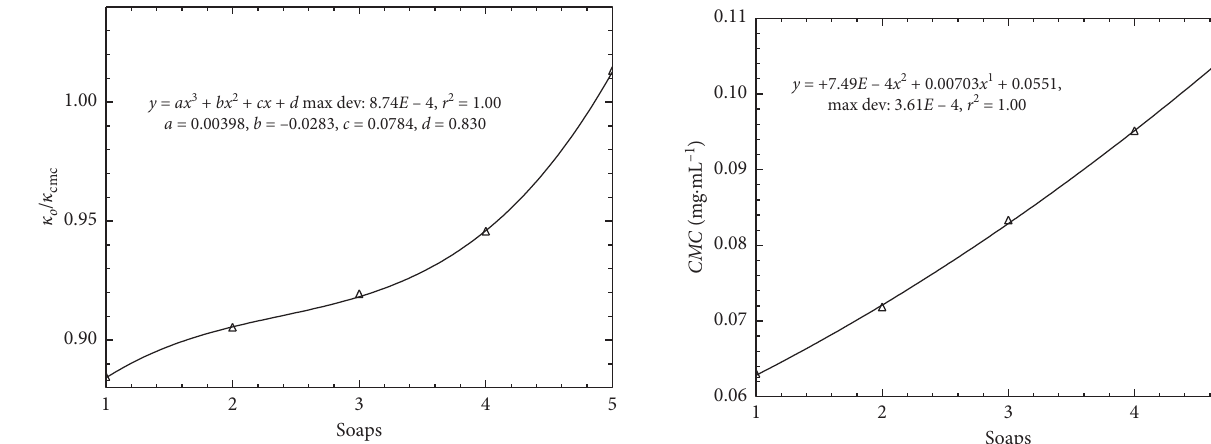
NM (2), OKT (3), LRL (4), and LX (5).